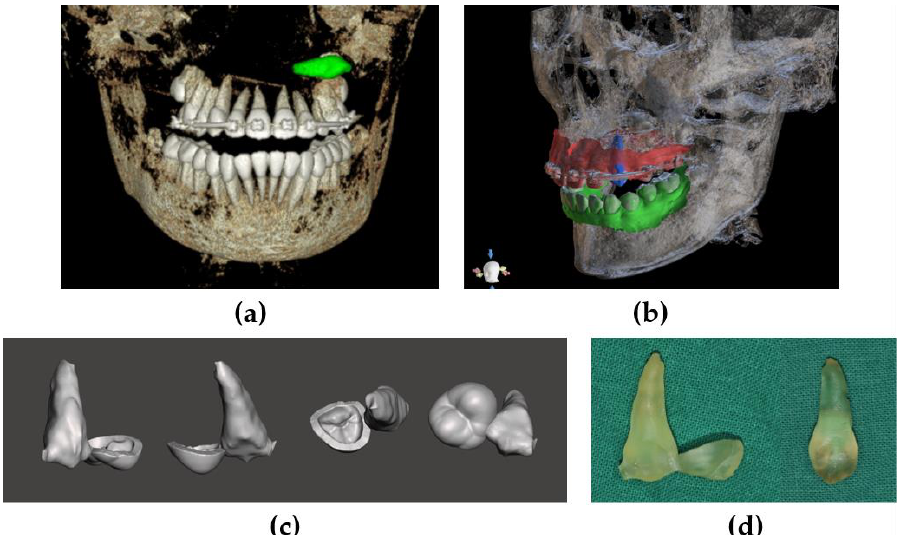
Figure 6. Surgery planning and fabrication of a surgical template. ( a ) segmentation of impacted canine; ( b ) virtual surgery planning using CBCT and intraoral scan images; ( c ) design of a surgical template; ( d ) 3D-printed surgical template and tooth replica.